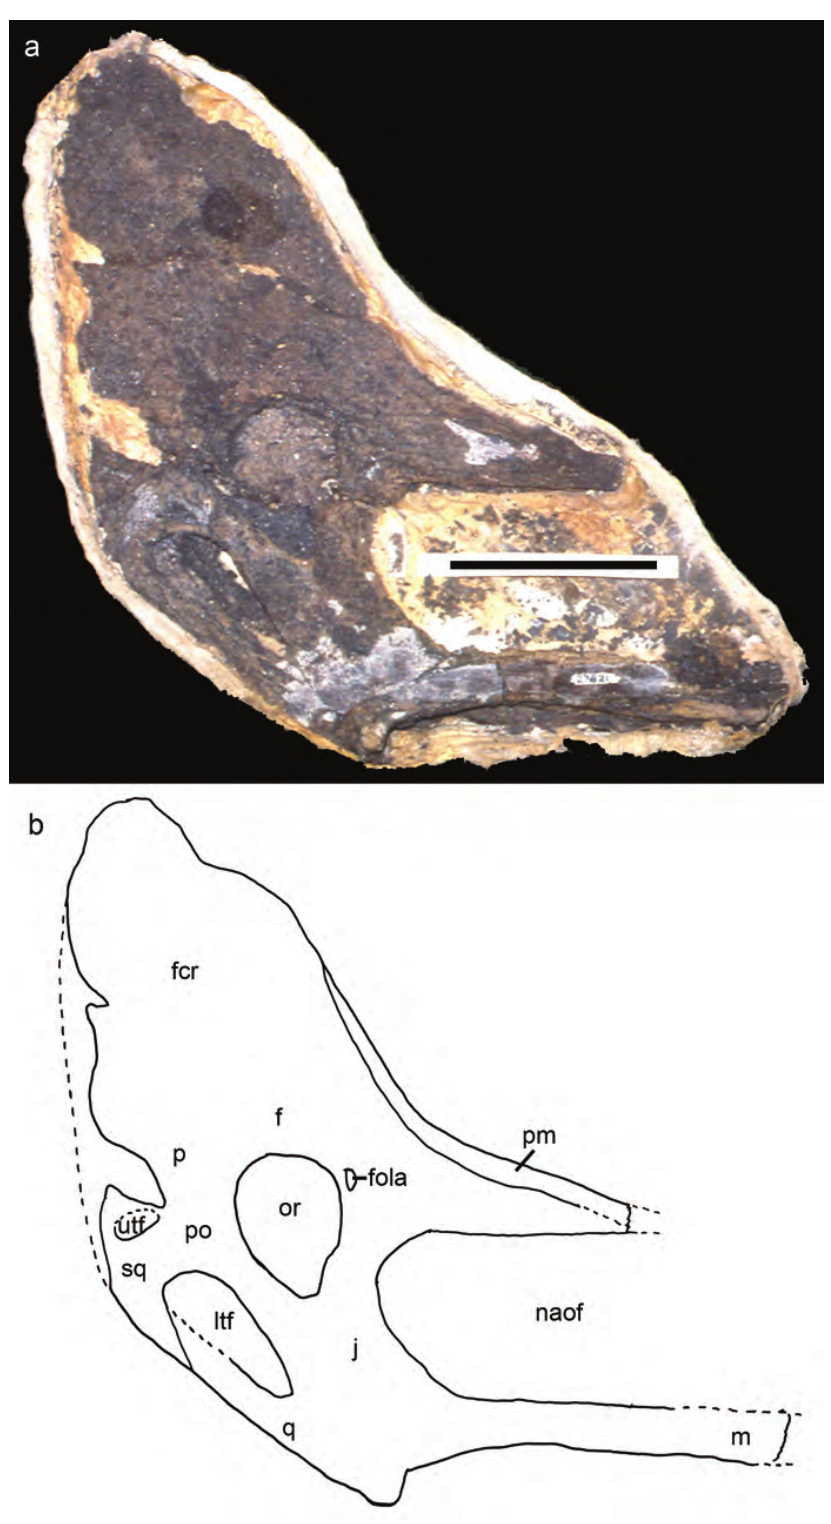
Fig. 1 – Geosternbergia maiseyi sp. nov., holotype (KUVP 27821). (a) photograph and (b) sketch of the skull. Scale bar: 100